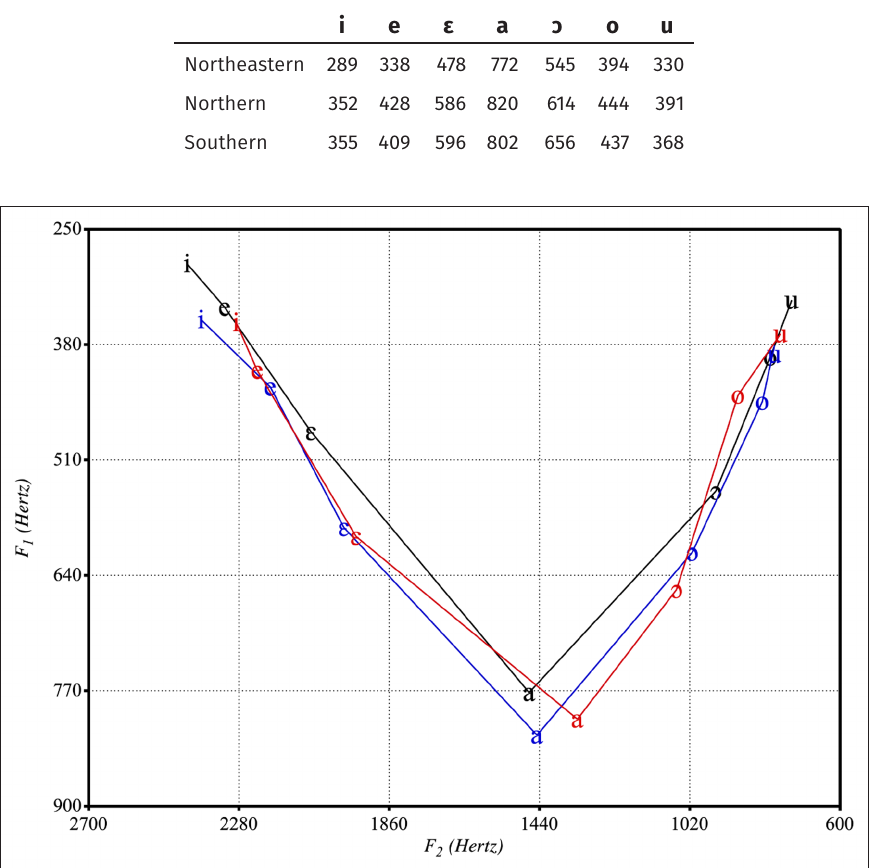
Table 4: F1 geometric means (in Hz) of the stressed vowels in the three dialects.